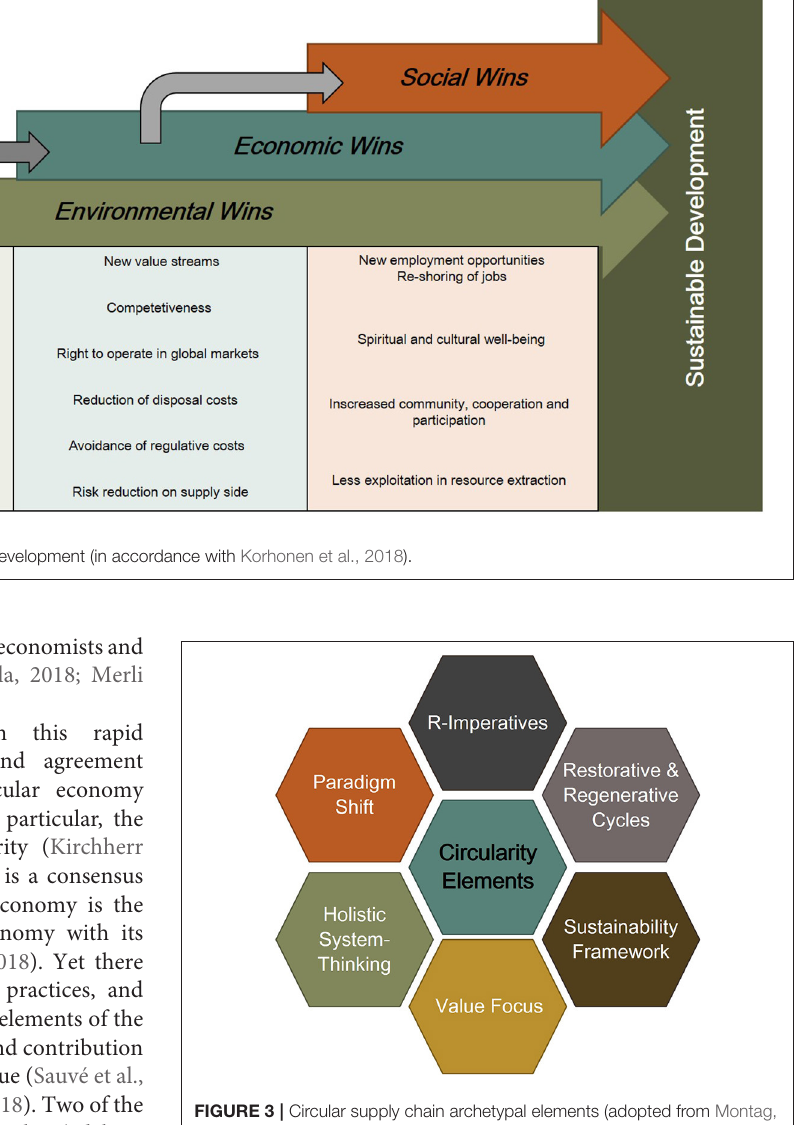
FIGURE 3 | Circular supply chain archetypal elements (adopted from Montag,